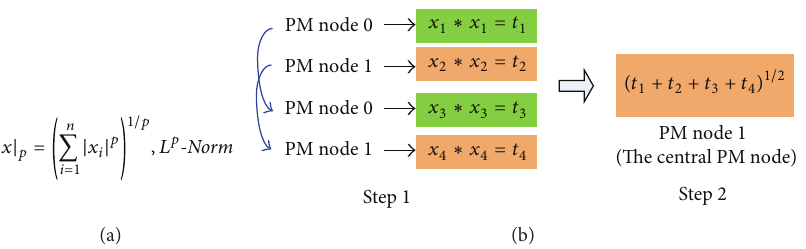
Figure 10: (a) Vector Norm and (b) its parallelization.